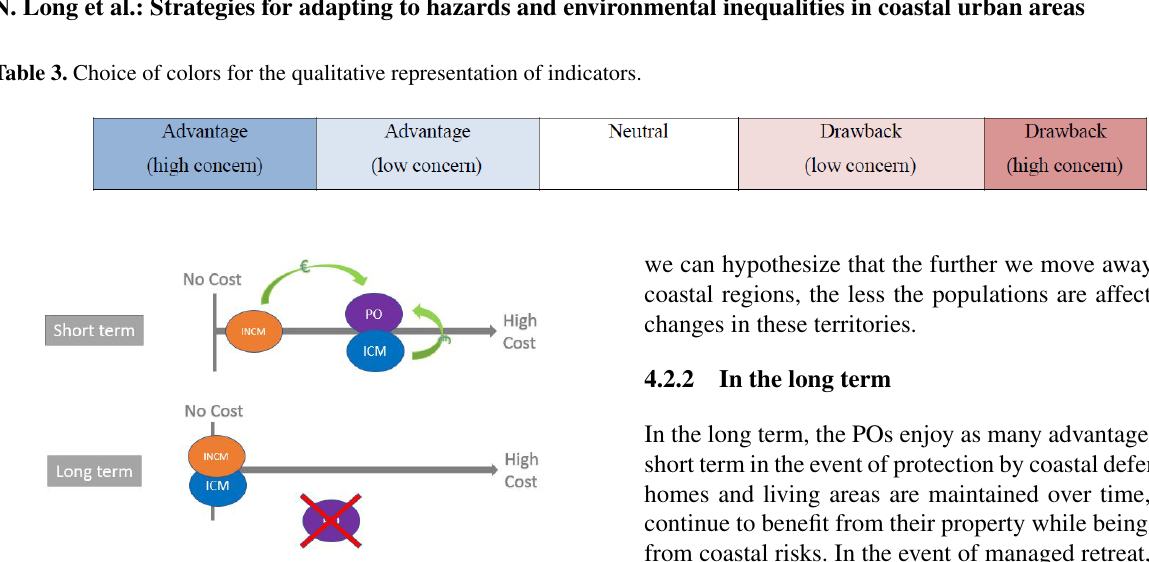
Figure 3. Evolution of cost for the “managed retreat”